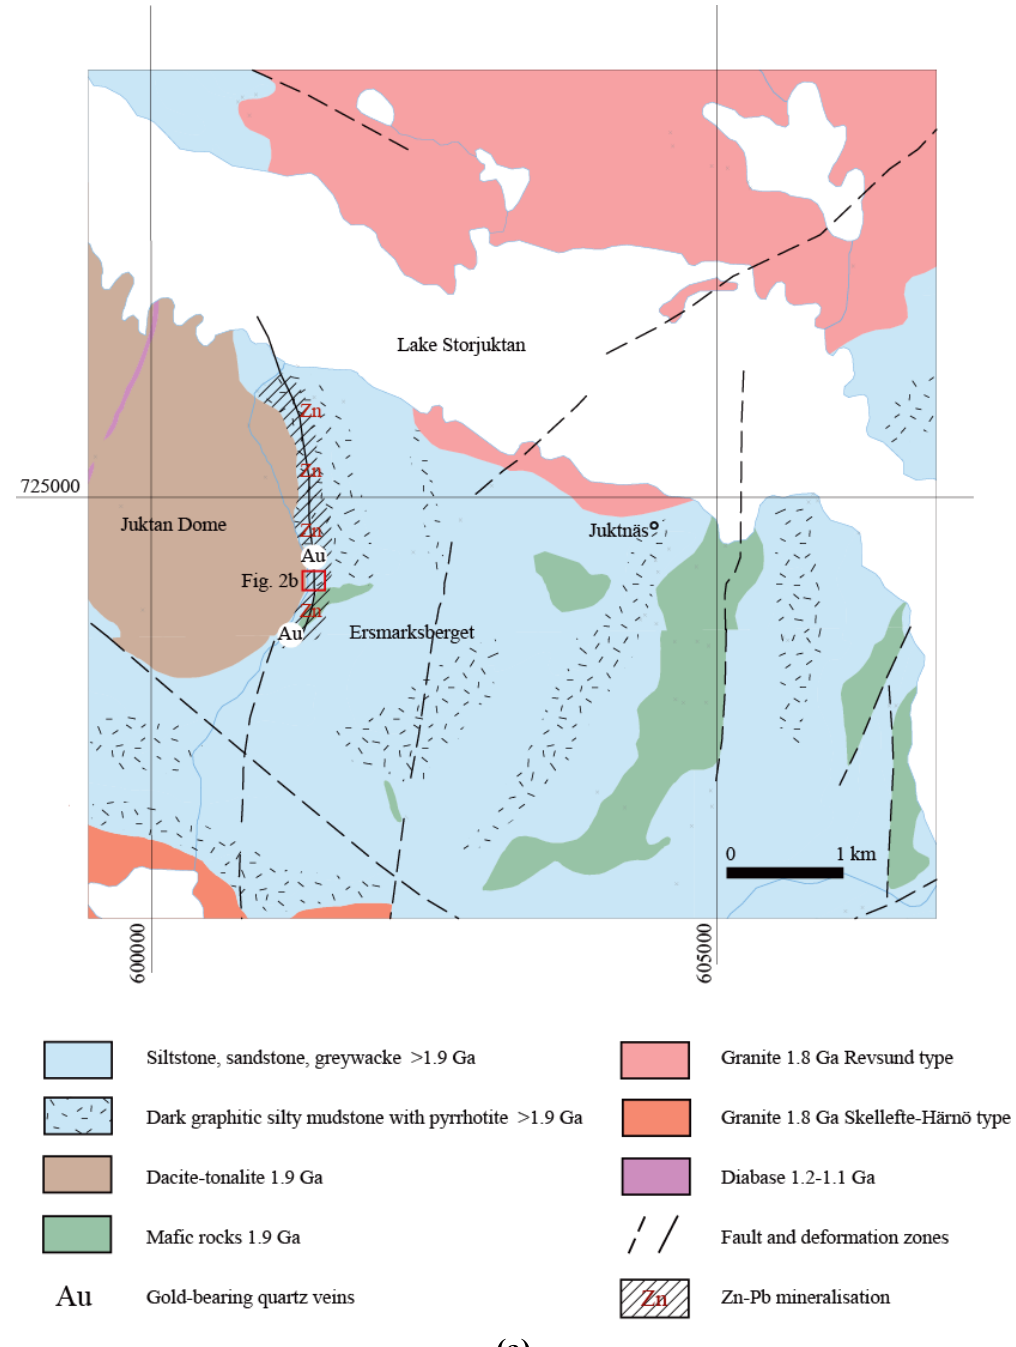
Figure 2. ( a ) Geological map of the Ersmarksberget Zn-Pb deposit and its surroundings; ( b ) Detailed geological map of part of the Ersmarksberget open pit showing the distribution of visible Zn/Pb mineralisation usually hosted by minor faults (certain zones with manifested abundance of one or several of the following phases; sphalerite, galena and fluorite are outlined). Sampling was carried out at similar sites in the mudstone along the eastern Juktan Dome contact. Coordinates in Figures 2–4 refer to the Swedish National Grid, RT